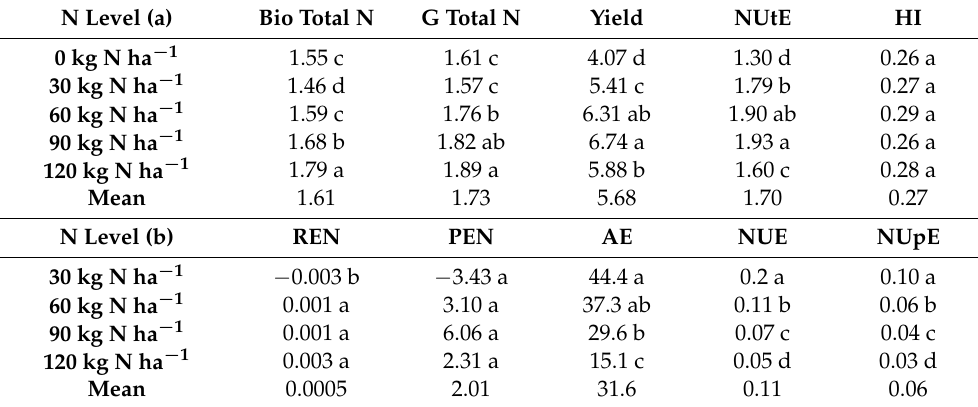
Table 3. Mean values of all the variables estimated at different levels of nitrogen